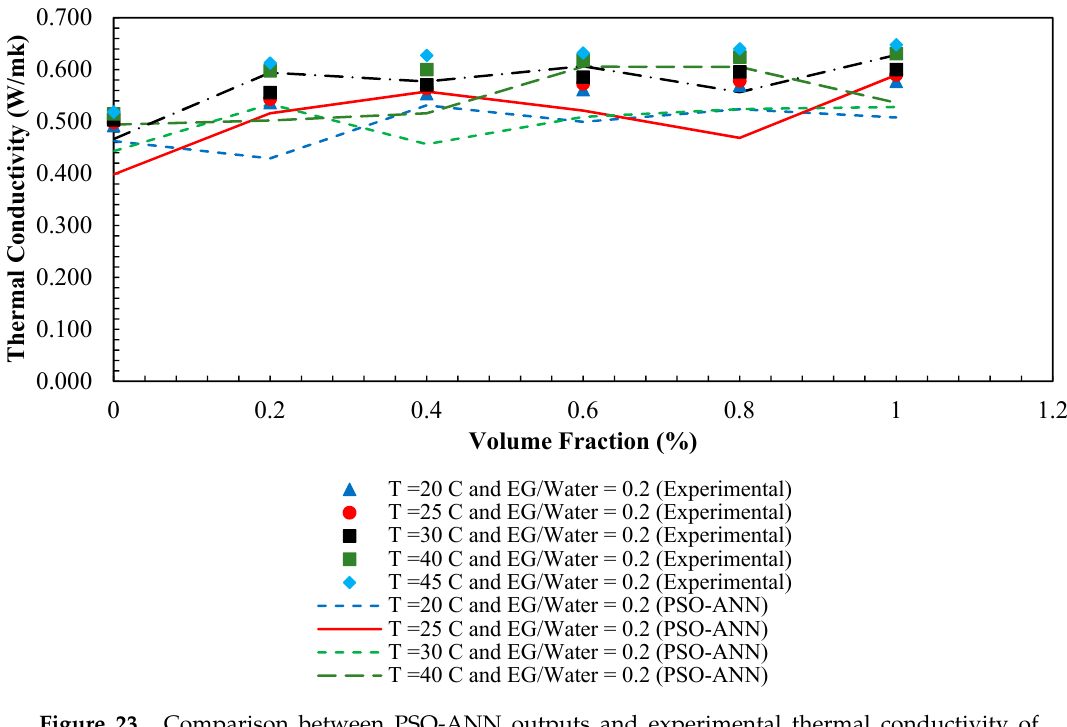
Figure 23. Comparison between PSO-ANN outputs and experimental thermal conductivity of Fe 2 O 3 /ethylene glycol-water nanofluid, versus volume fraction (%) at different condition. Table 6. Calculated statistical indexes of the implemented intelligence-based approaches for thermal conductivity of Fe 2 O 3 /ethylene glycol-water nanofluid determination. Statistical Parameter LSSVM